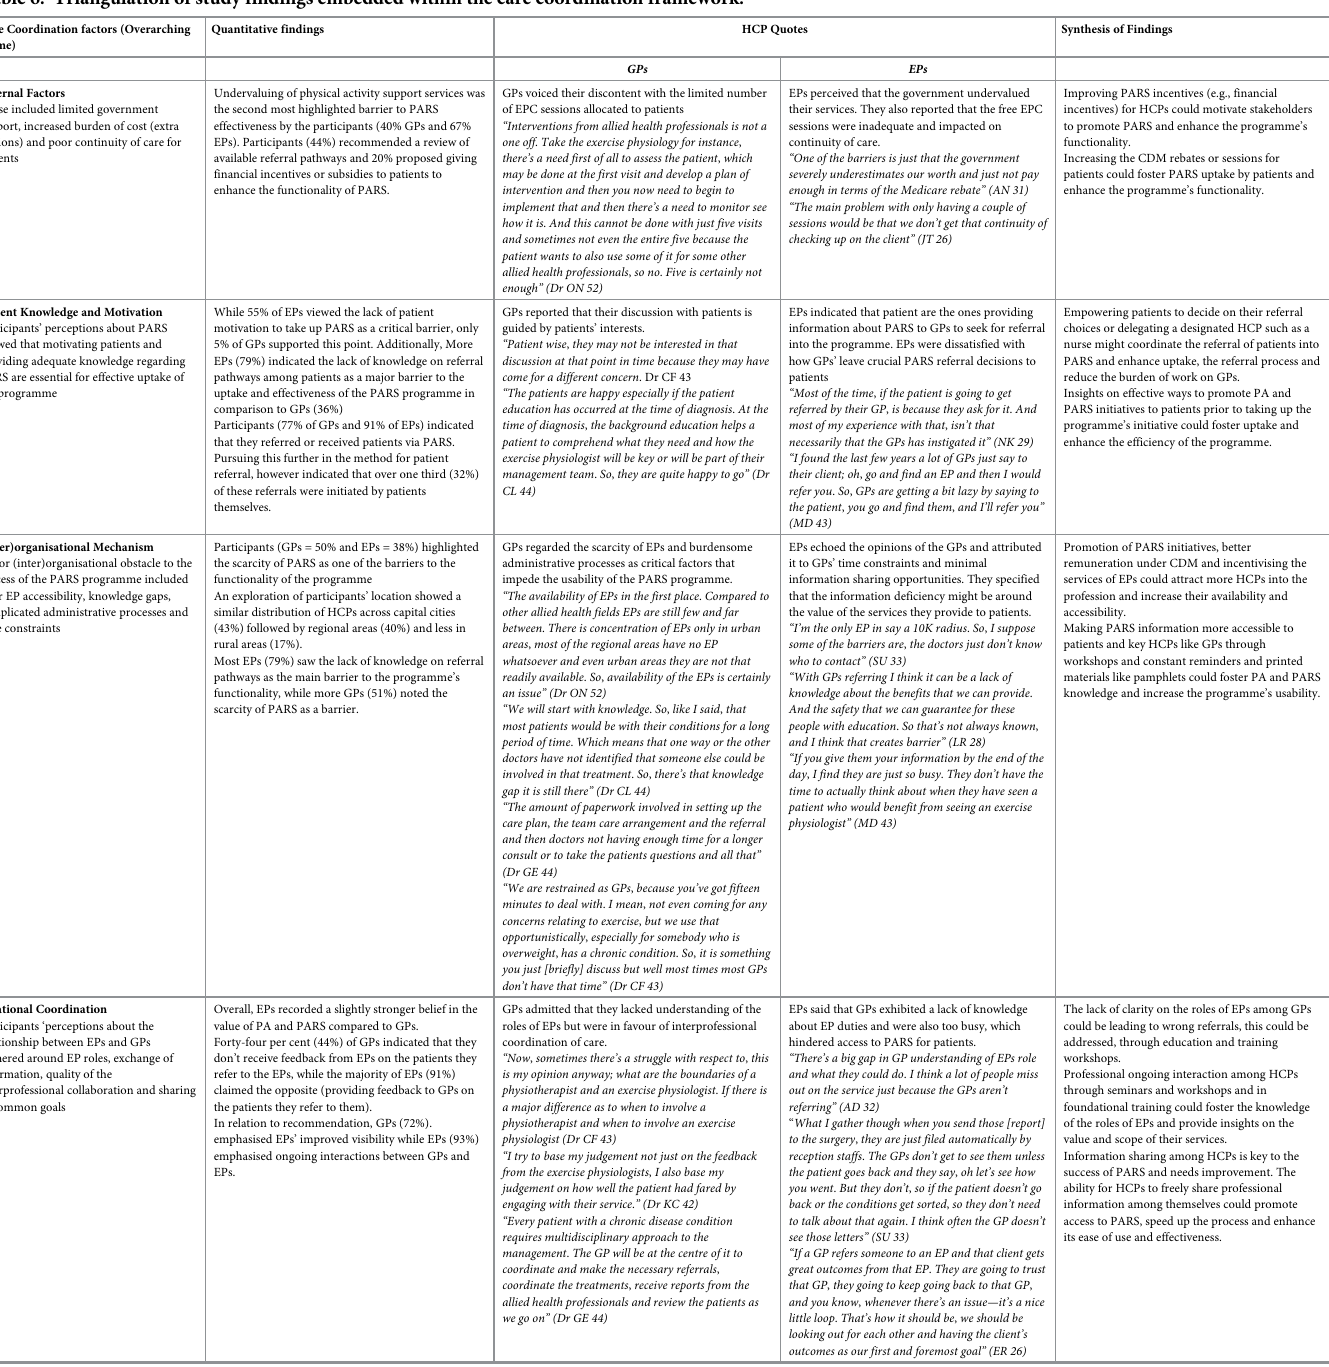
Table 6. Triangulation of study findings embedded within the care coordination